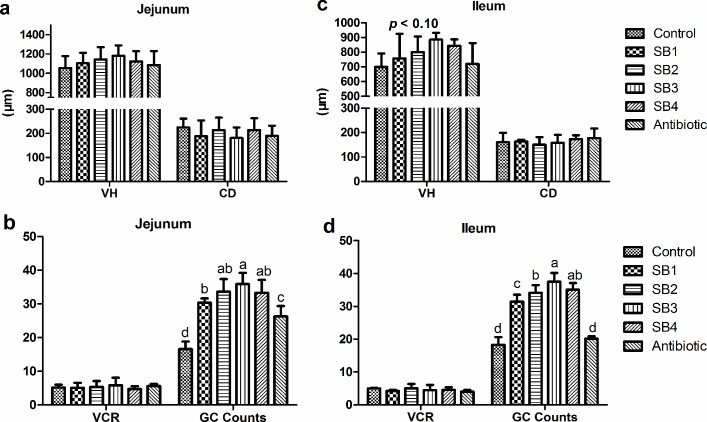
Intestinal histomorphological indices of the jejunum and ileum in broilers.Bars labeled with different letters are significantly different (P<0.05), the same as follows. (a, c) VH, villus height (μm); CD, crypt depth (μm); (b, d) VCR, the ratio of VH to CD; GC, goblet cell. Treatments: Control, basal diet; SB1, basal diet supplemented with 200 mg/kg sodium butyrate; SB2, basal diet supplemented with 400 mg/kg sodium butyrate; SB3, basal diet supplemented with 800 mg/kg sodium butyrate; SB4, basal diet supplemented with 1000 mg/kg sodium butyrate; Antibiotic, basal diet supplemented with 100 mg/kg aureomycin and 20 mg/kg colistin sulfate, the same as follows.